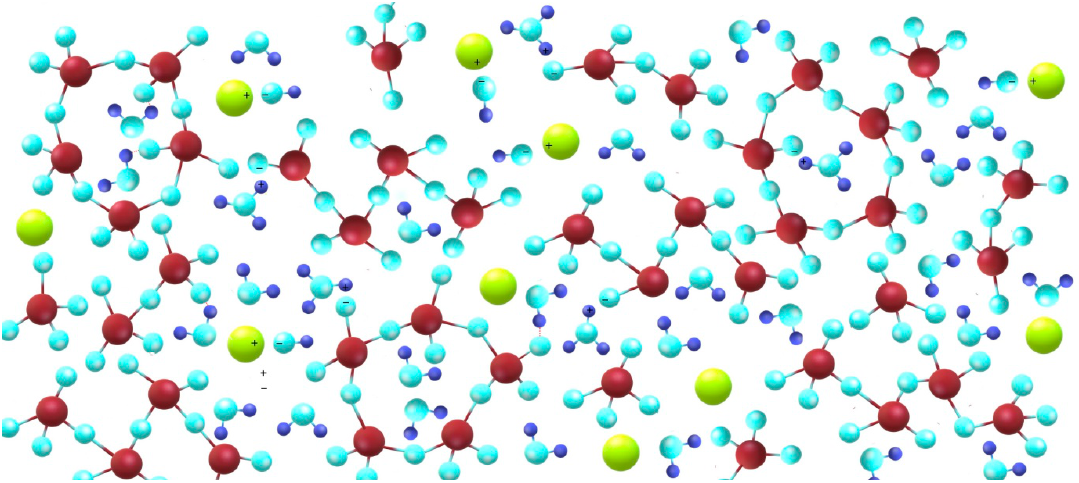
Figure 1. Schematic diagram of the water glass structures (dark red—silicon, light blue—oxygen, dark blue—hydrogen, green—sodium).